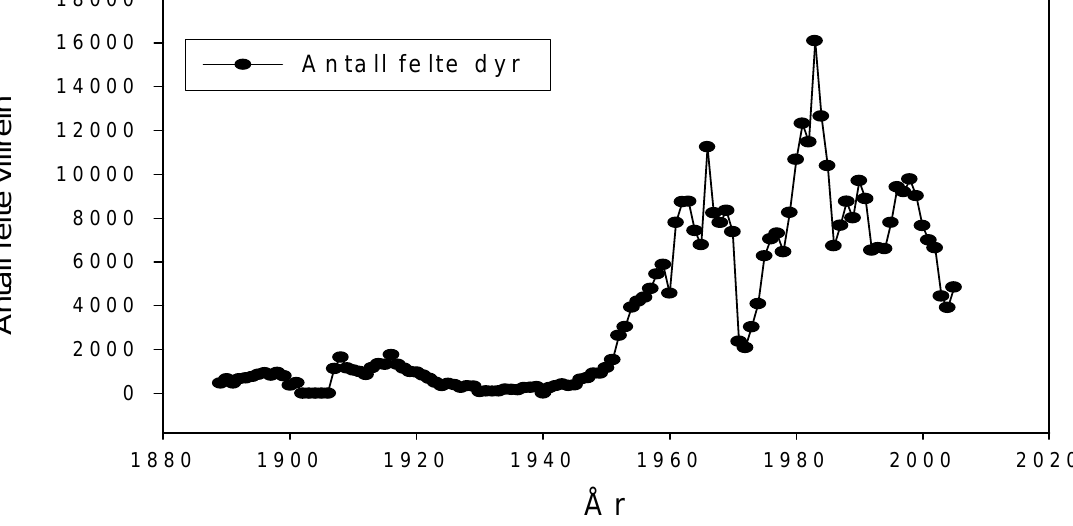
Fig. 1. Fellingsstatistikk for villrein i perioden 1889 til 2005 (Statistisk sentralbyrå).